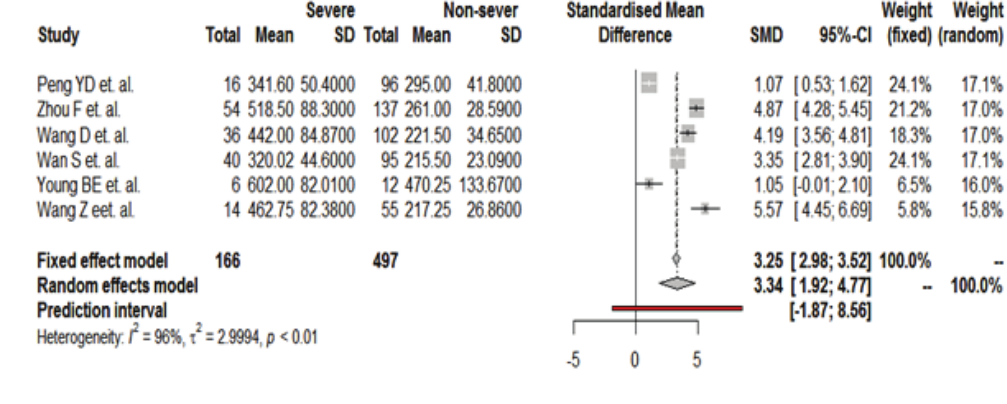
Figure 5: Pooled SMD of LDH estimates between the two groups of patients (severe and non-severe COVID-19).